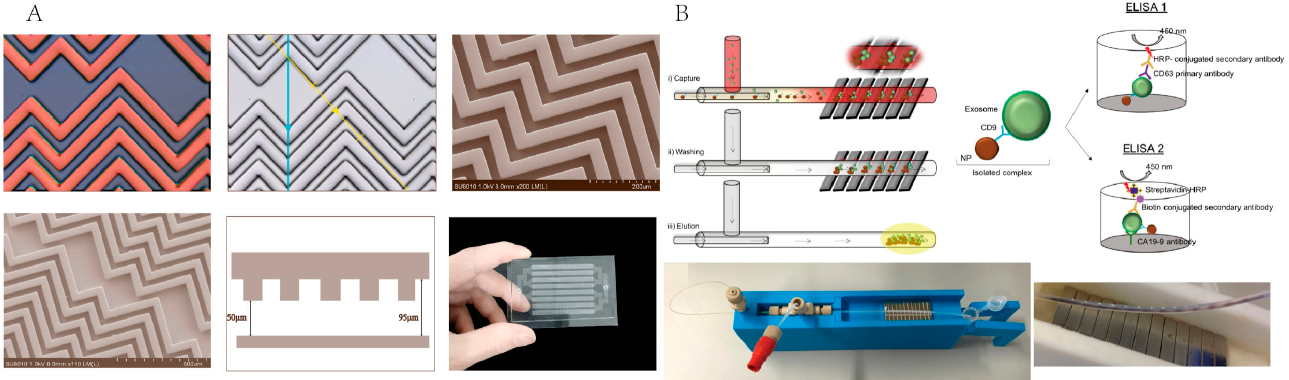
Figure 8. Microfluidic technology for exosome isolation based on immunoaffinity. ( A ) Schematic of the structure of HB EXO-Chip for exosomes isolation. Reprinted with permission [51]. ( B ) Schematic of microdevice used magnetic nanoparticles functionalized with antibodies for exosomes isolation. Reprinted with permission